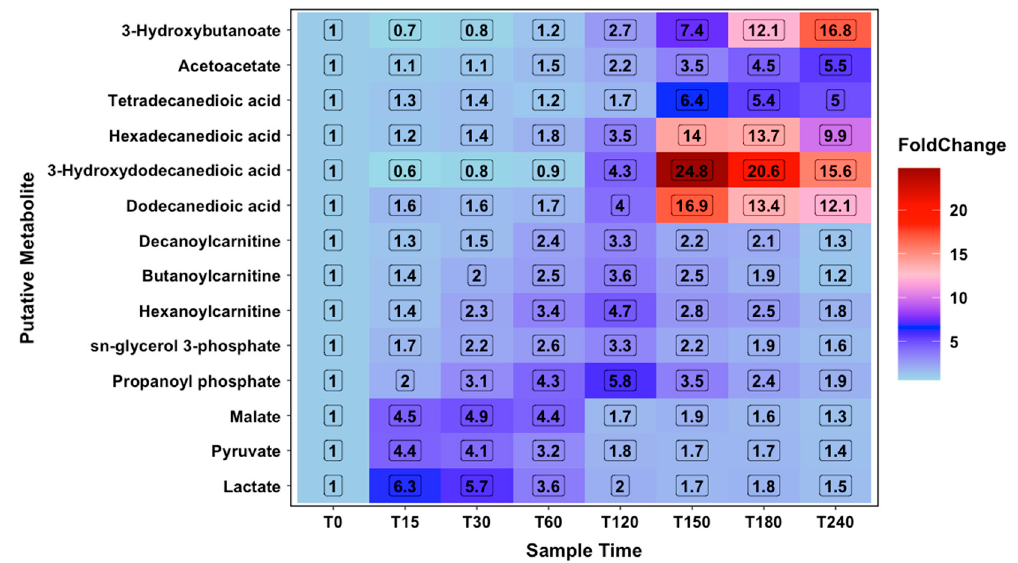
Figure 4. Metabolites showing fold changes across glycolytic and ketolytic energy metabolism pathways. Fold change values coloured from blue to red as fold change increases.